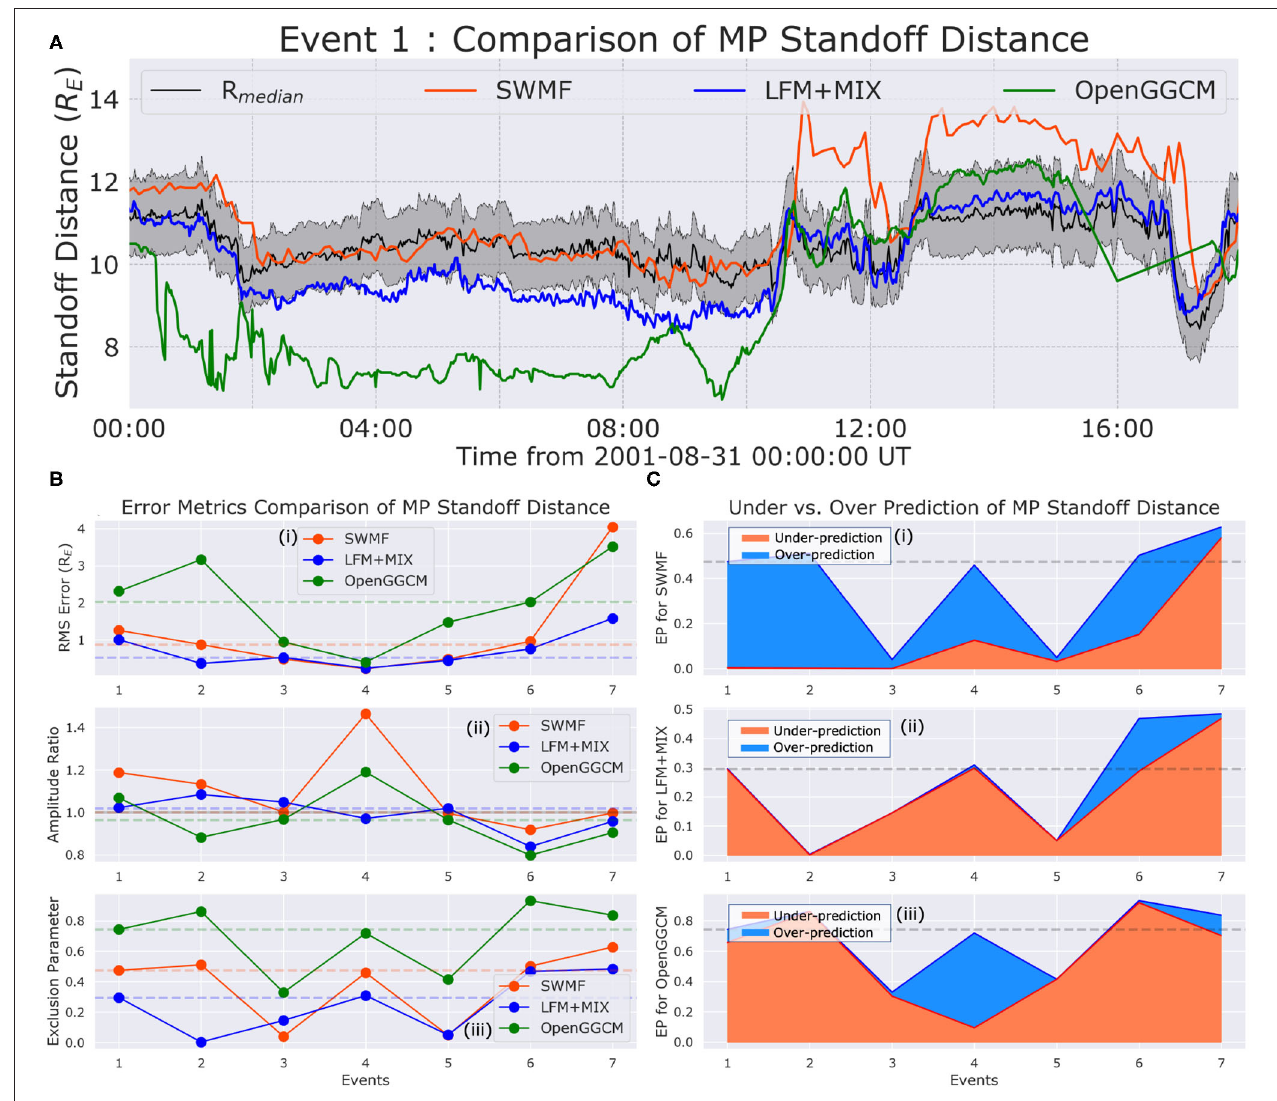
FIGURE 1 | Analysis of the MHD-predicted magnetopause standoff distances against the empirical models – (A) An example time-transient comparison of the magnetopause distances during Event 1 from SWMF (in red), LFM+MIX (in blue), and OpenGGCM (in green) compared against the six empirical magnetopause models which have been shown here as a range of values demarcated by the gray band, with the black line in the center of the band being the median value. (B) Comparison of (i) RMS Error, (ii) Amplitude Ratio, and (iii) Exclusion Parameter for the three models across all 7 events (in same color scheme as Top plot). The dashed lines in the background signify the median value of these metrics across all events. (C) Comparison of the Underprediction and Overprediction score from the Exclusion parameter. The results have been separately presented for (i) SWMF, (ii) LFM+MIX, and (iii) OpenGGCM, with orange signifying underprediction of values, and light-blue indicating overprediction. The overpredicted values are plotted atop the underpredicted values.